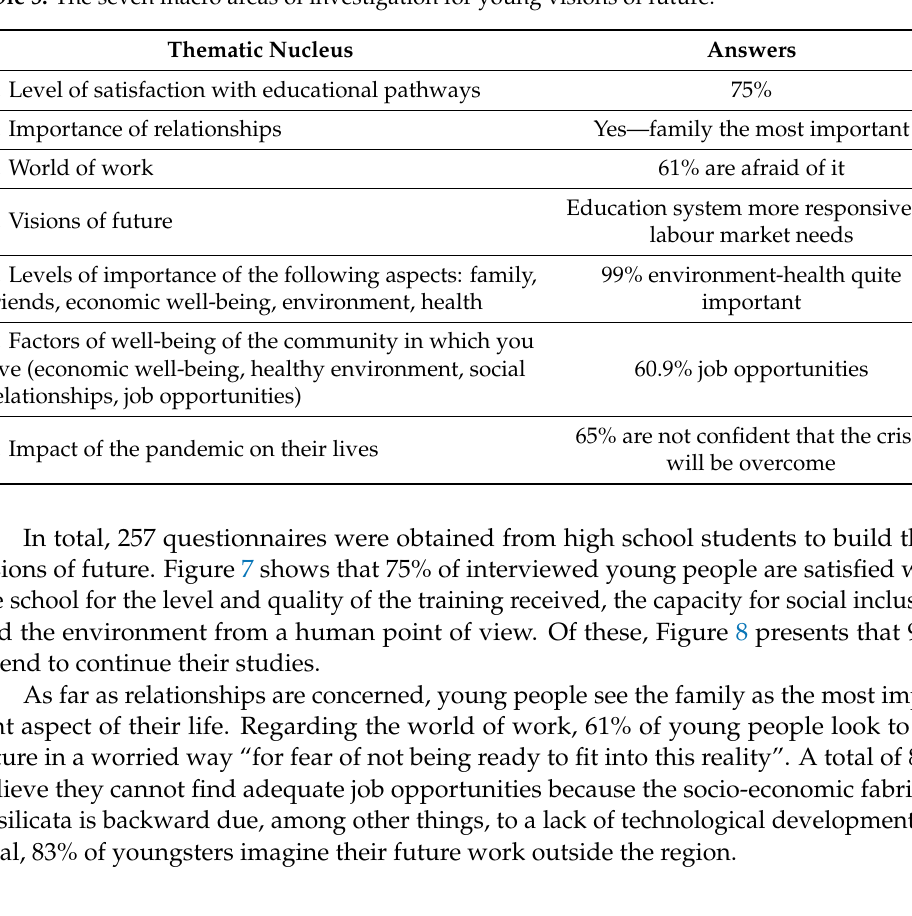
Table 5. The seven macro areas of investigation for young visions of